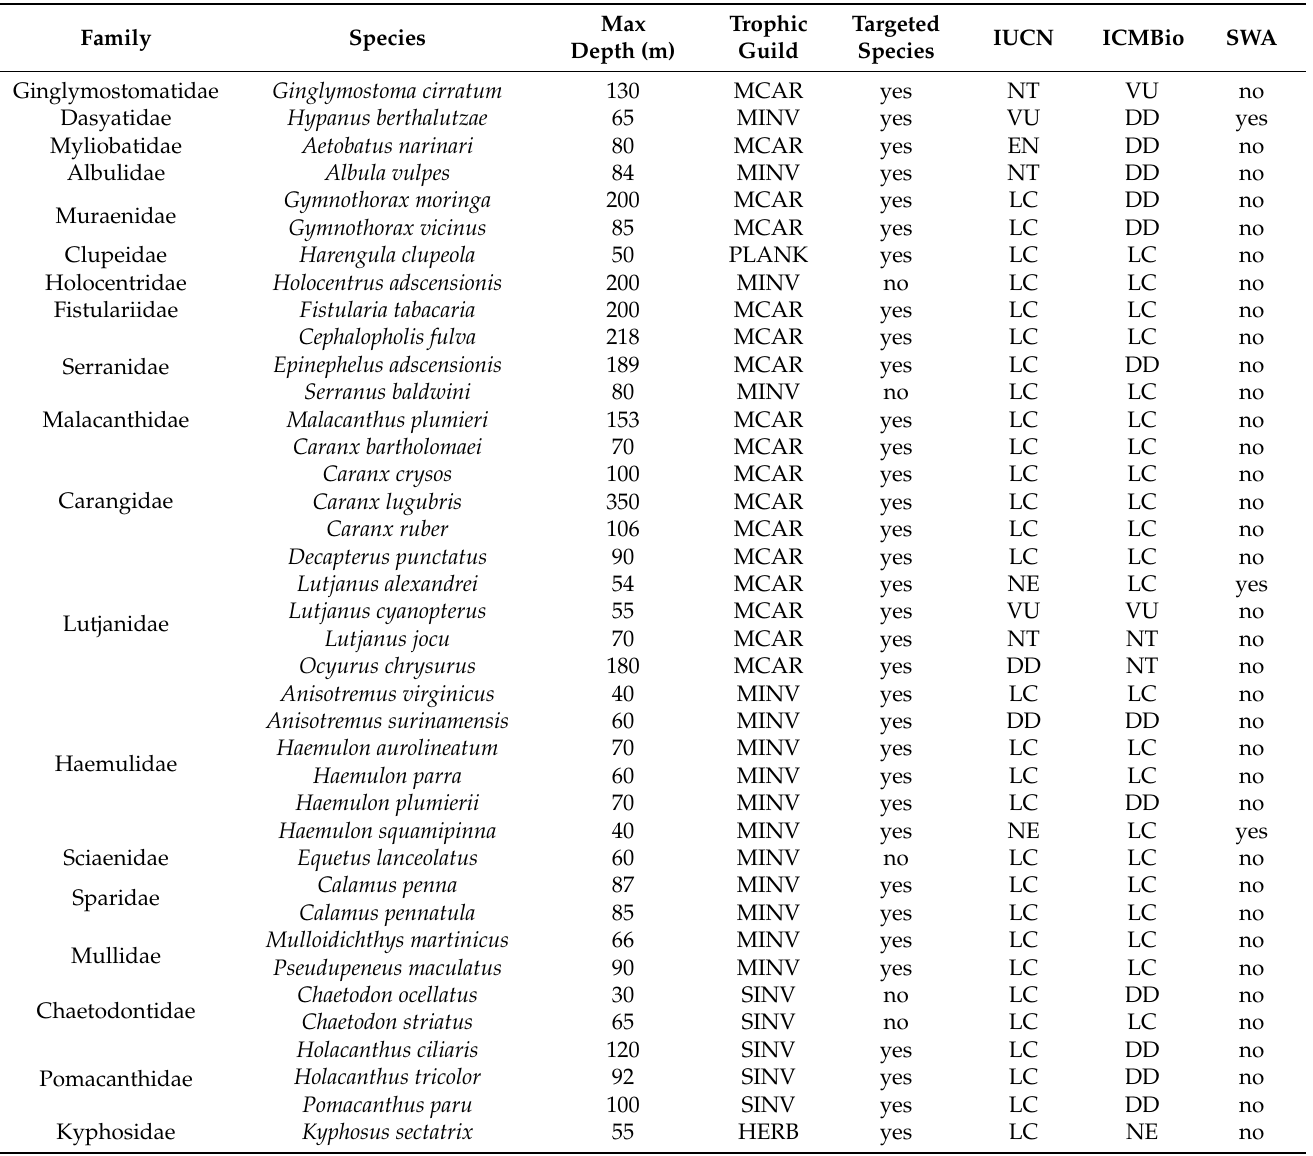
Table 2. Reef fish traits in the mesophotic zone of Marine Protected Area Costa dos Corais, Brazil. Trophic guild: HERB = herbivore/detritivore; MCAR = carnivore; OMNI =